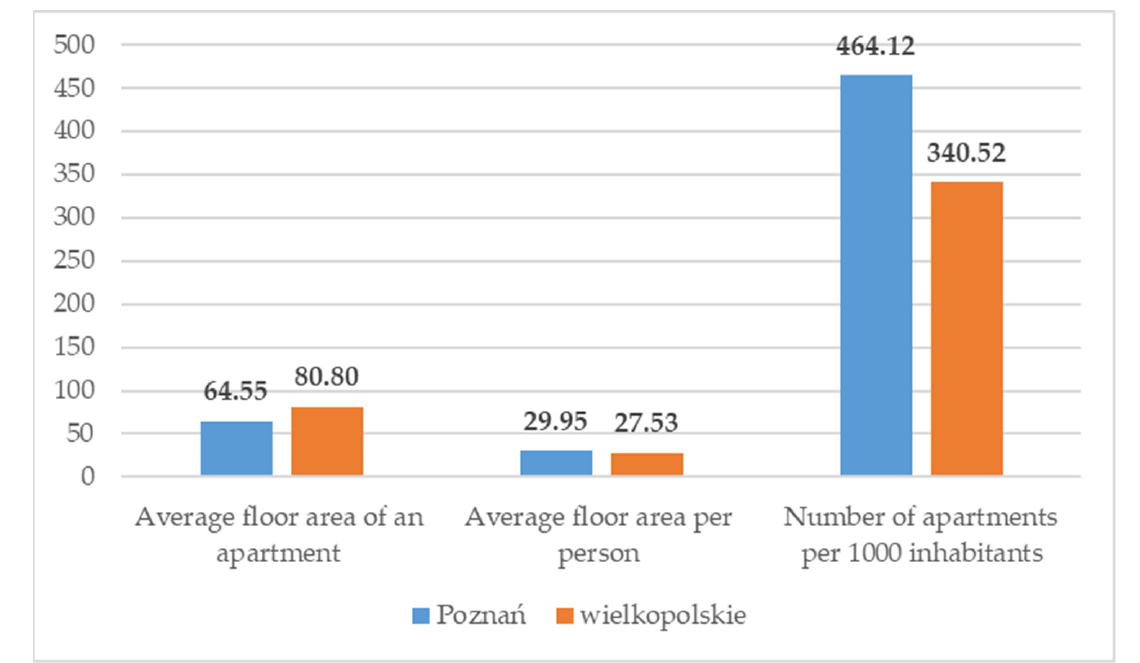
Figure 12. Indicators of housing infrastructure availability in Pozna ń and the Wielkopolska Province.